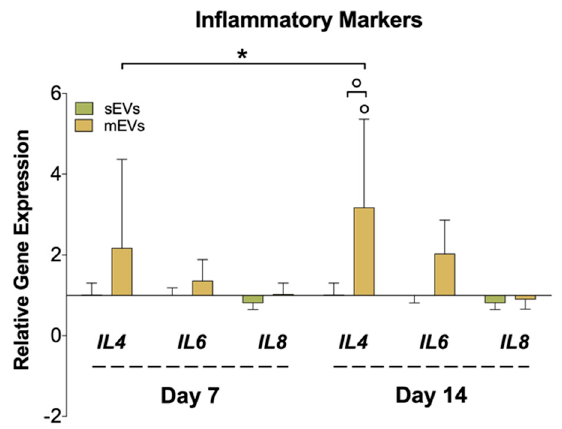
Figure 4. Gene expression of inflammatory markers (interleukin-4; -6; -8 ( IL4 , IL6, and IL8 )), after 7 and 14 days of culture with EVs. The target gene expression was normalized against glyceraldehyde-3-phosphate dehydrogenase ( GAPDH ) and glucuronidase beta ( GUSB) and the data presented for the non-supplemented system each day (1) (n = 4). Statistical significances: * p < 0.05 (among days for the same group); ° p < 0.05 (between sEVs and mEVs or against the control for the same day).